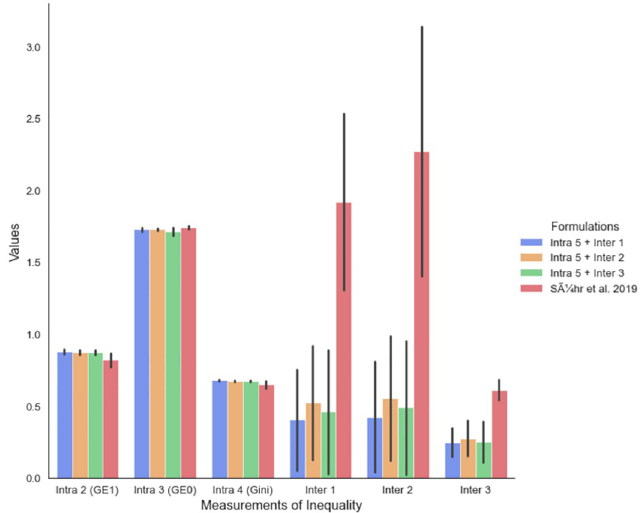
Fig 1. Experimental results of four formulations implemented for 5 trials (4 × 5 runs in total), in DOcplex, with different batch of jobs from NYC taxi dataset and different d ð i ; j Þ 20 implementations are denoted as bars, while the black vertical line on top of each bar denotes the mean ± one standard